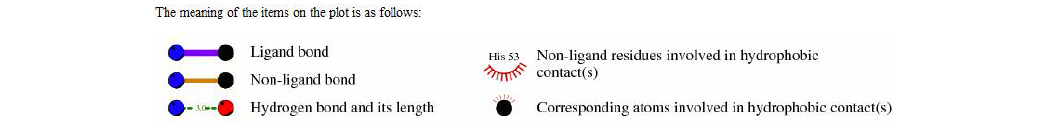
Figure 8: Protein-ligand interaction of Complex Ornithine Decarboxylase_9,12-Octadecadienoic acid (Z,Z)- Note: 9,12-Octadecadienoic acid (Z,Z)- (ligand) form two hydrogen bonds (represented as green broken lines with bond length) with amino acid Gly237 and Gly276 of ornithine decarboxylase